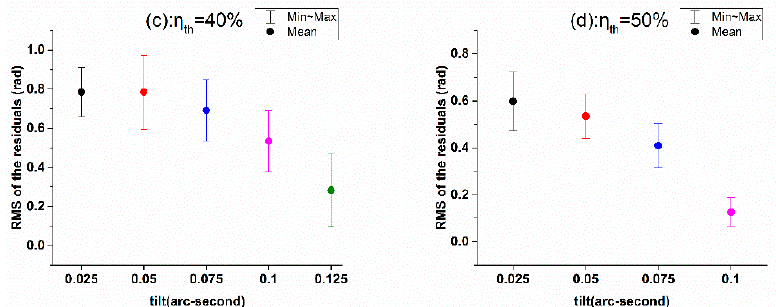
Figure 7. Processed data under different coupling thresholds ( η th ). ( a ) η th = 20%; ( b ) η th = 30%; ( c ) η th = 40%; ( d ) η th = 50%.